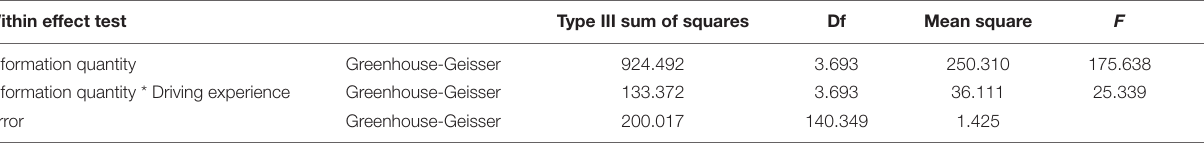
TABLE 10 | The information amount factor main effect and interaction effect of the experience factor.